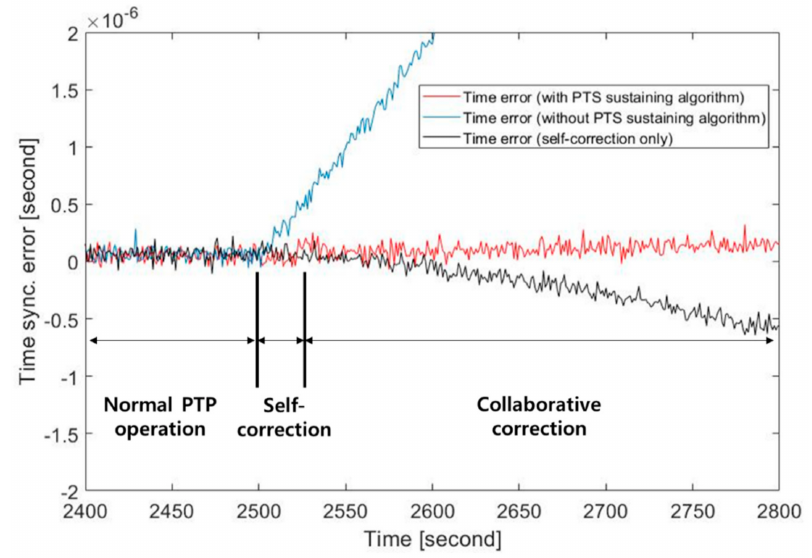
Figure 7. Comparison of time synchronization performance of precision time protocol (PTP) clocks.